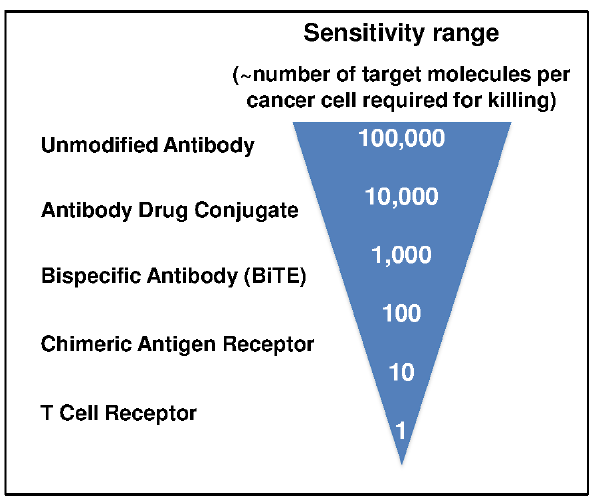
Figure 2. Sensitivity thresholds for various antibody or T-cell-based therapy modalities. A comparison of approximated sensitivity thresholds (that is, number of target molecules per cancer cell that are required for killing) that have been identified for antibody or T-cell-based approaches is depicted. Note that these are estimates and that within each category the sensitivity can be further influenced by various parameters, including the affinity of the receptor toward the target antigen. BiTE, bispecific T-cell